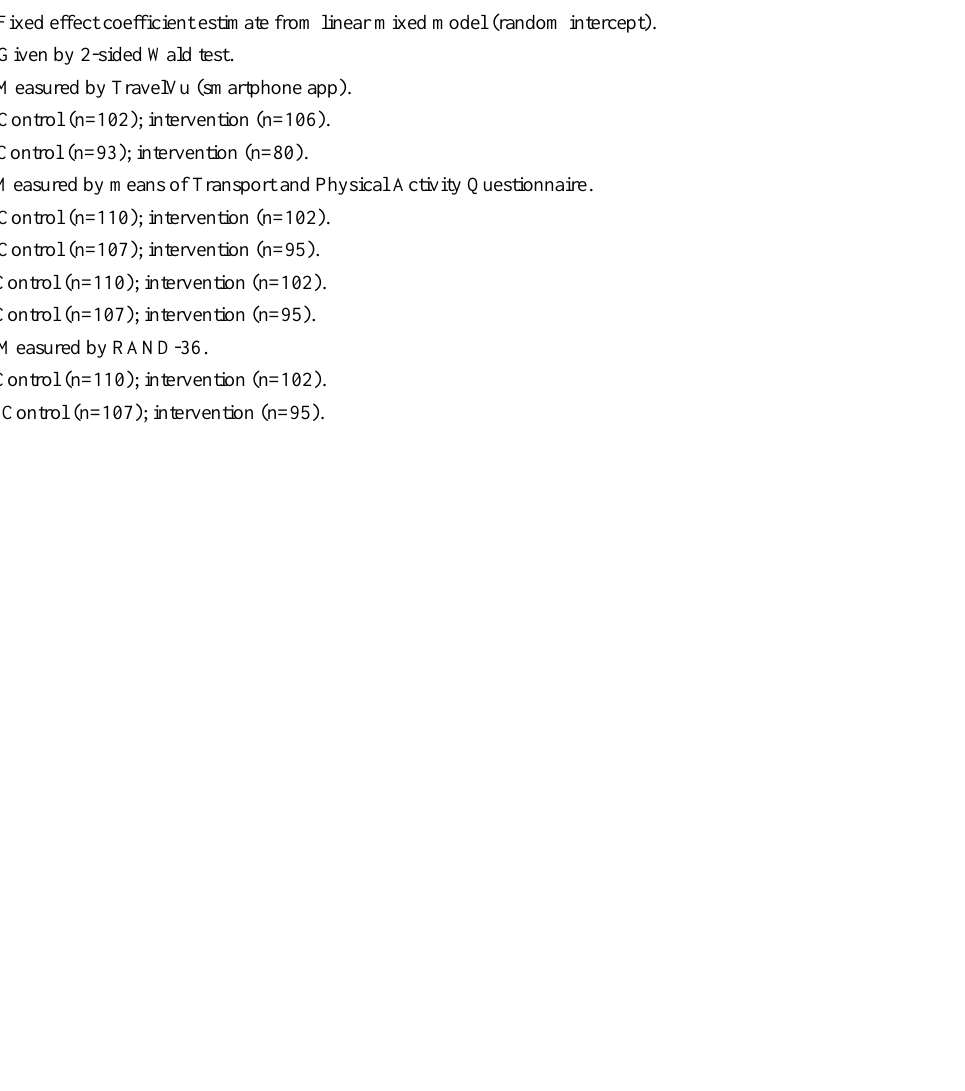
Group × time interaction a Sample, mean